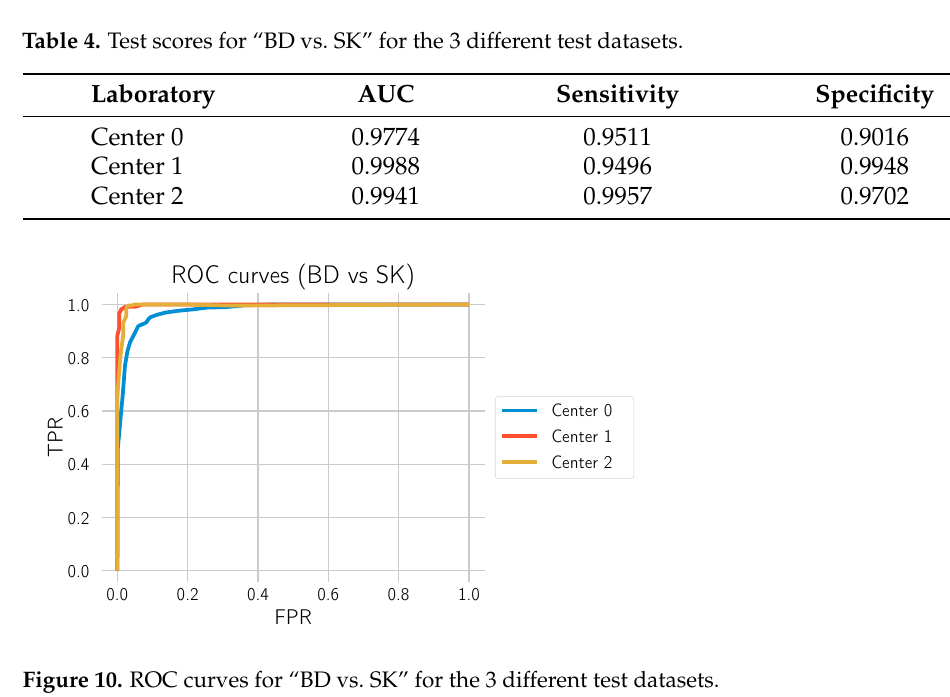
Figure 10. ROC curves for “BD vs. SK” for the 3 different test datasets.